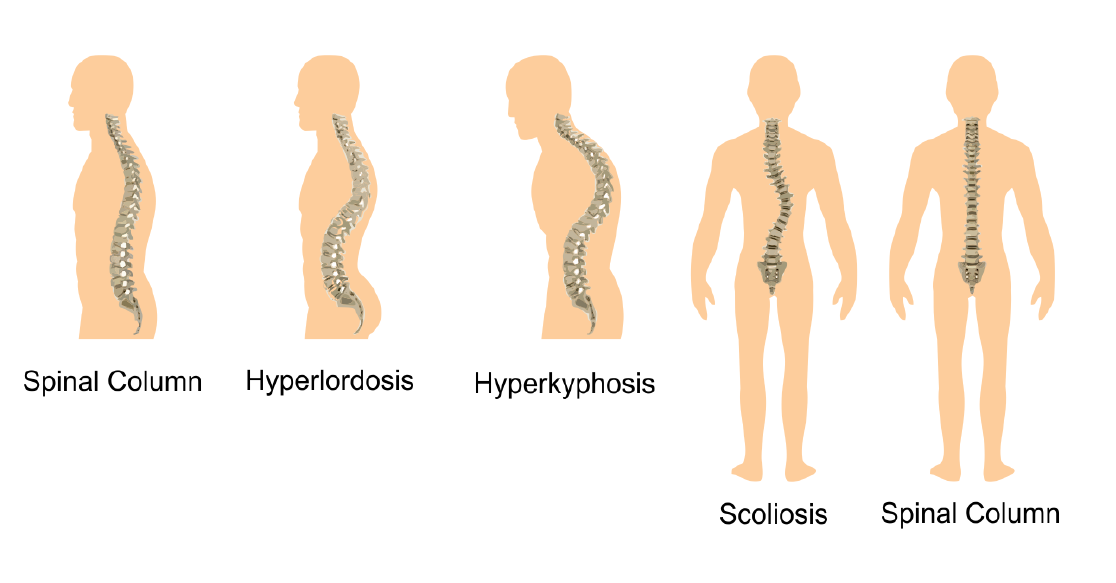
Figure 1. Postural